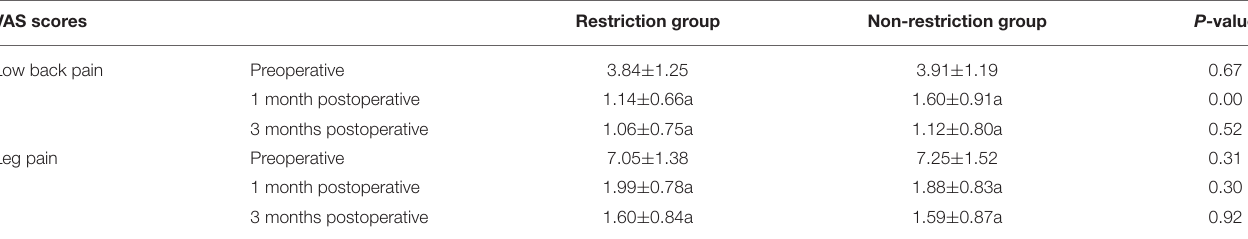
TABLE 2 | Comparison of VAS scores.